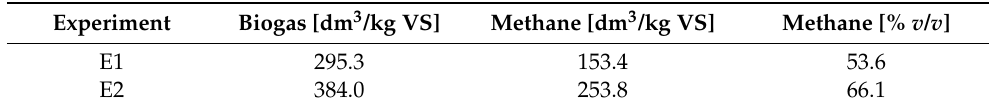
Table 5. Accumulation of biogas and methane over a 25-day fermentation